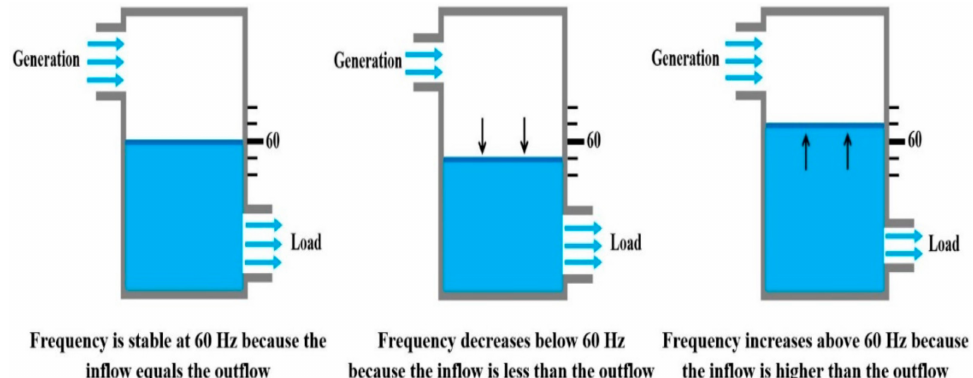
Figure 8. Concept of grid’s frequency stability, using the water-level in a container analogy